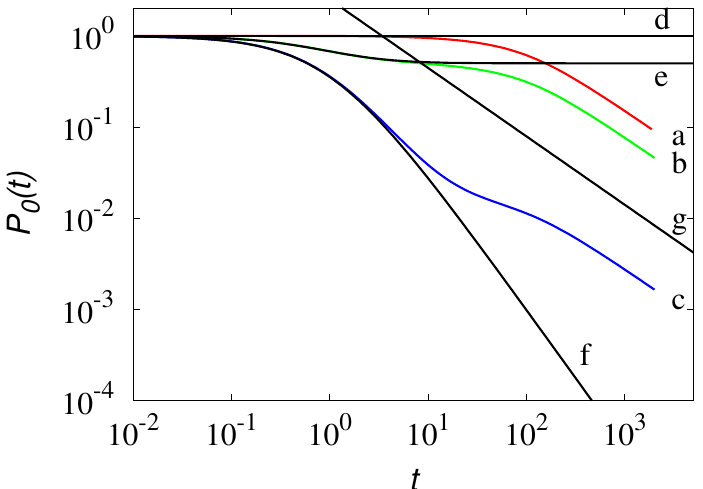
Figure 8. Influence of the initial condition π + on P 0 ( t ) for the ES counting process depicted in 0 Figure 6 panel (a), ξ = 1.5. Lines (a) to (c) refer to π 0 + = 0,0.5,1, respectively. Lines (d) to (f) are the corresponding short-term approximations expressed by Equation